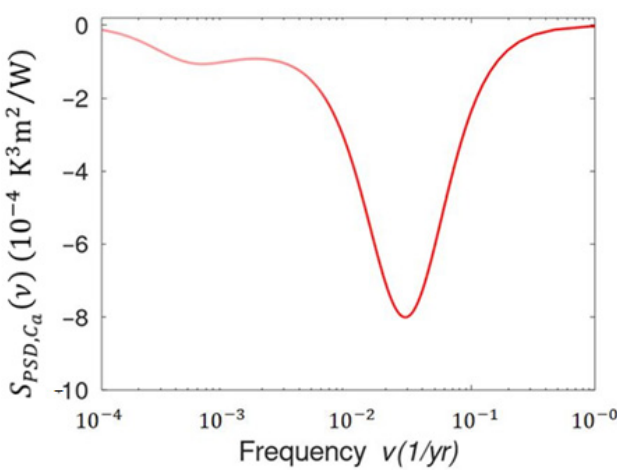
Figure 9. Sensitivity function of power spectral density of the global mean surface temperature fluctuations with respect to the mixed ocean layer thermal inertia, determined by the effective heat capacity C a